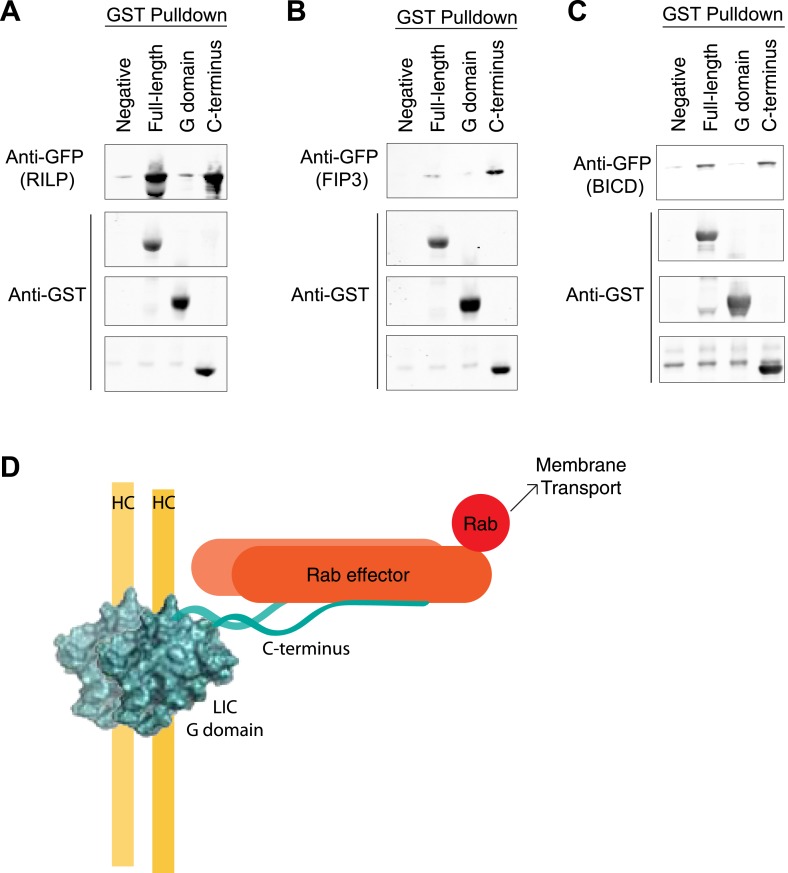
The LIC C-terminus alone binds Rab effectors.(A) Human GST-tagged full-length LIC and LIC truncations, including the G domain (a.a. 1–389) and the C-terminus (a.a. 389–523), were purified from E. coli bound to glutathione beads and incubated with recombinant GFP-FIP3. The beads were centrifuged, washed, and probed with an anti-GFP antibody to assess binding of the GFP-tagged protein. (B) The same experiment in (A) was done with GFP-RILP. (C) The same experiment in (A) was done with GFP-BicD2. (D) A model depicts the LIC G domain bound to the dynein heavy chain (HC) with the C-terminus bound to a Rab effector, allowing for membrane transport by dynein.